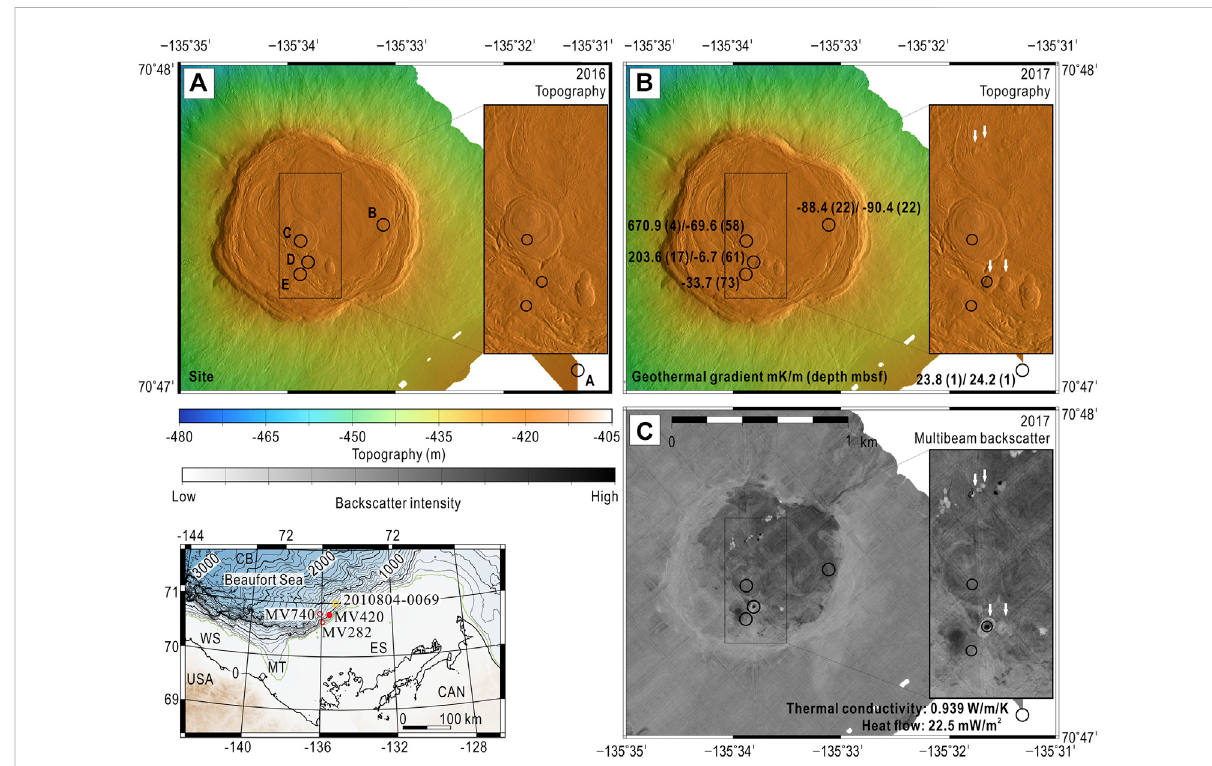
FIGURE 1 Acousticsurveyresultswiththeautonomousunderwatervehicle(AUV)inMV420.Multibeamechosounderbathymetryobtainedin2016 (A) and 2017 (B) , and backscatter intensity images from the multibeam echosounder in 2017 (C) are shown. New mound morphologies (white arrows in Figure subset B) formed in 1 year. Five sites (A to E in Figure subset (A) and the observed geothermal gradient (numbers in Figure subset B) with penetrating depth (numbers with parentheses in Figure subset B) for each site are depicted in Table 1. Thermal conductivity and heat fl ow are shown in (C) . The inset exhibits regional bathymetry of the Canadian Beaufort Sea and the location of three mud volcanoes (red circles): MV282, MV420 (closed), and MV740 (Paull et al., 2015). The comparison site for sediment bulk density is 2010804 – 0069 (orange square) (MacKillop et al., 2022). The subsea permafrost limit is considered to follow an isobath of water depth ~100 m below sea level (dashed green line) (Taylor et al., 2013). WS, Western Shelf; MT, Mackenzie Trough; ES, Eastern Shelf; CB, Canadian